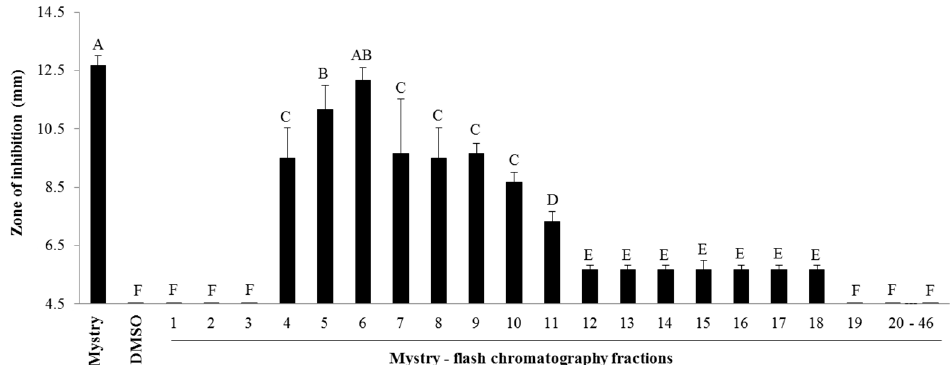
Figure 2. Zones of inhibition of 46 Mystry fractions from column chromatography. 20–46: fraction 20 through fraction 46. If no inhibition was observed in samples, a value of 4.5 mm, which was the diameter of the wells in agar-well diffusion experiments, was assigned. Means within bars followed by different letters are significantly different ( α = 0.05, ANOVA). Mean ± SEM.